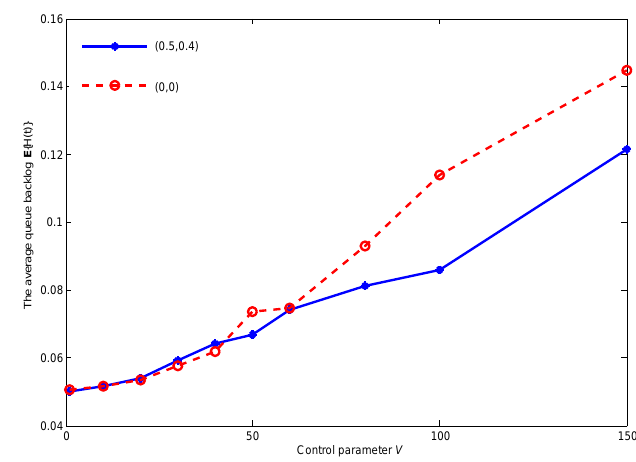
Fig. 5. The average queue backlog versus the control parameter V under different cache control variables ( q { 1 }